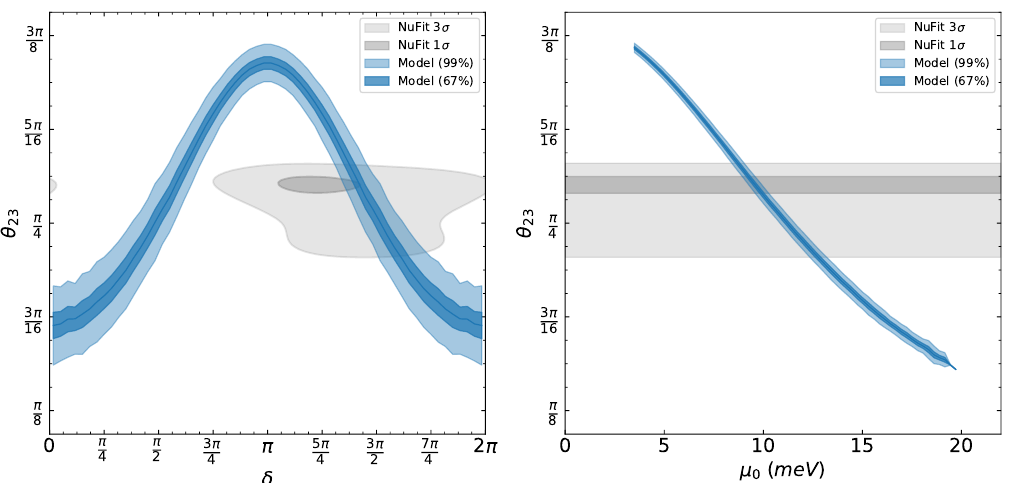
Figure 1 . Left panel: functional dependence of (cid:18) 23 vs. (cid:14) at the C 0 = 0 absolute minimum. The dark (light) gray region depicts the 1 (cid:27) (3 (cid:27) ) experimentally allowed limits from ref. [26]. The meaning of the dark and light blue regions is explained in the text. Right panel: same for (cid:18) 23 vs. (cid:22) 0